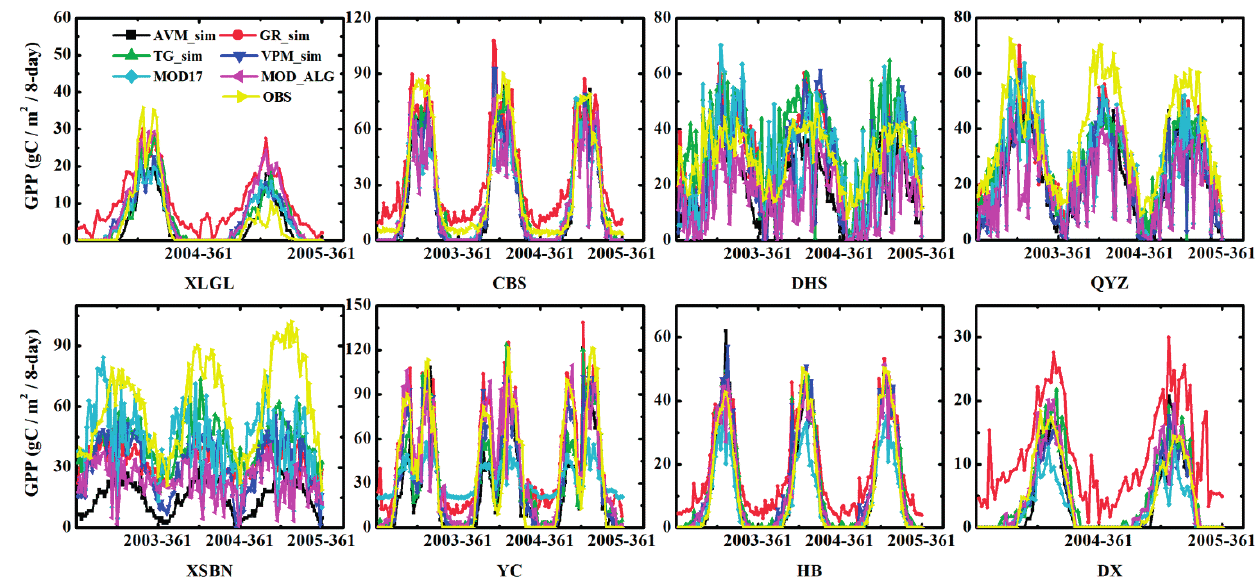
Figure 3. Seasonal variations of measured and estimated GPP for each site during the study period (2004–2005 for XLGL and DX; 2003–2005 for CBS, DHS, QYZ, XSBN, YC, and